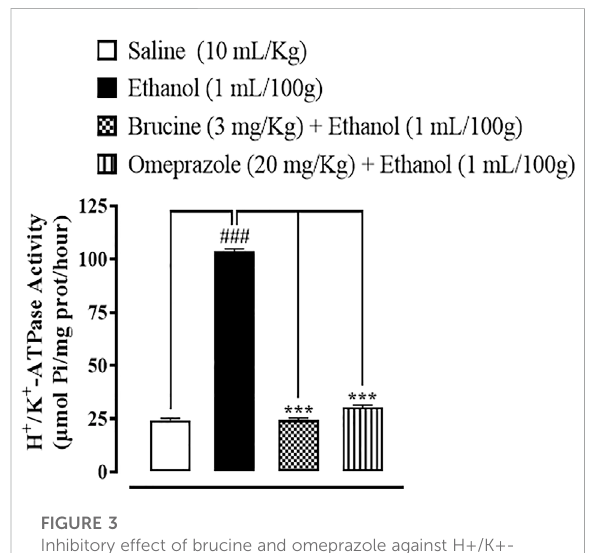
FIGURE 3 Inhibitory effect of brucine and omeprazole against H+/K+- ATPase in ethanol-induced ulcer rat gastric tissues. Values expressed as mean ± SEM ( n = 5). One-way ANOVA with post hoc